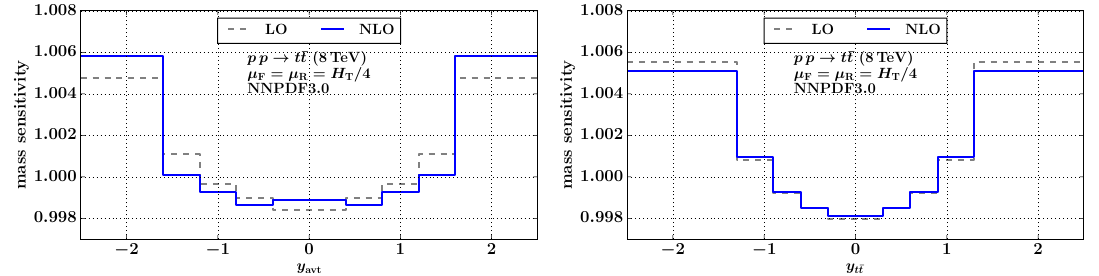
Figure 2 . The ratio between m t = 172 : 3 GeV and m t = 173 : 3 GeV (\mass sensitivity") at LO and NLO for the normalized y t (left) and y (right) distributions at 8 TeV, computed using t (cid:22) t